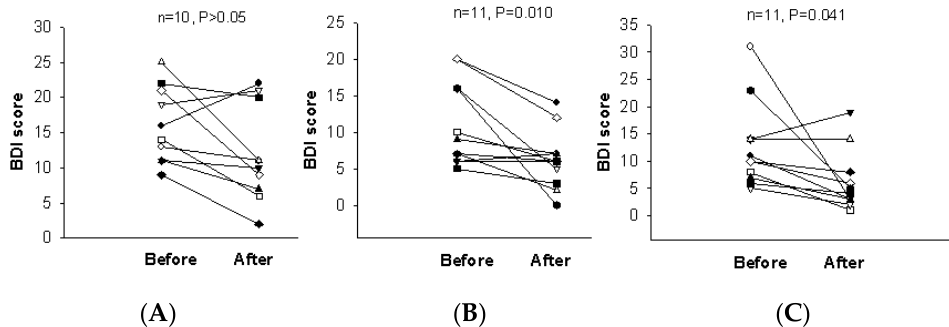
Figure 2. Differences in BDI mean scores between WNS and placebo groups. ( A ) Placebo group, ( B ) 2.4 g of WNS group, ( C ) 4.8 g of WNS group.